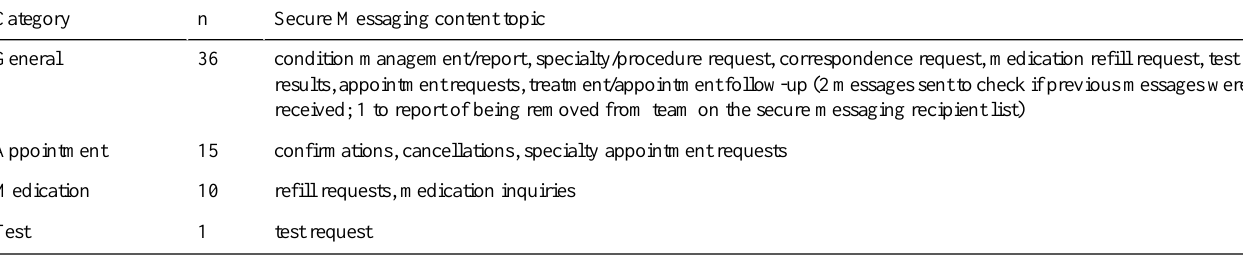
Table 9. Secure Messaging content topic by veteran-selected category. Secure Messaging content